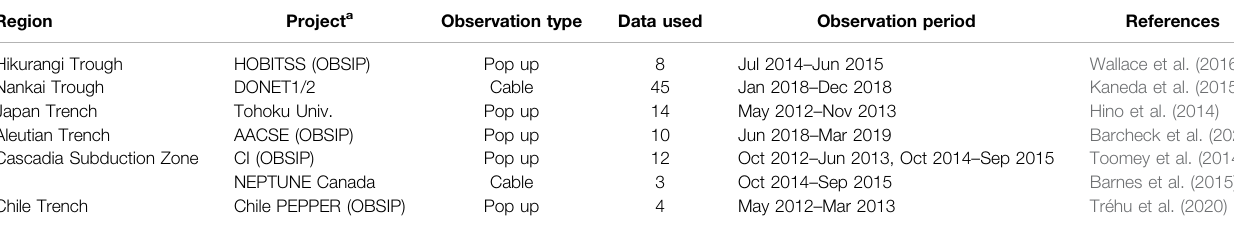
TABLE 1 | OBP observations and data.